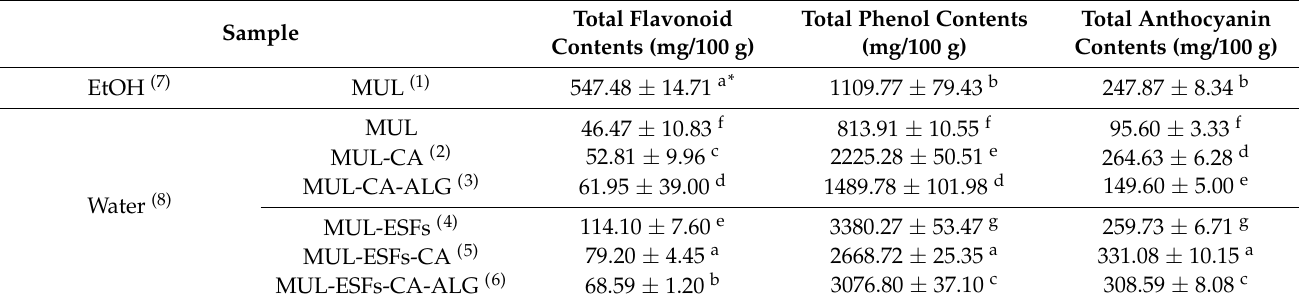
Table 1. The total flavonoid content, the total phenol content, and the total ATC content of MUL extract.